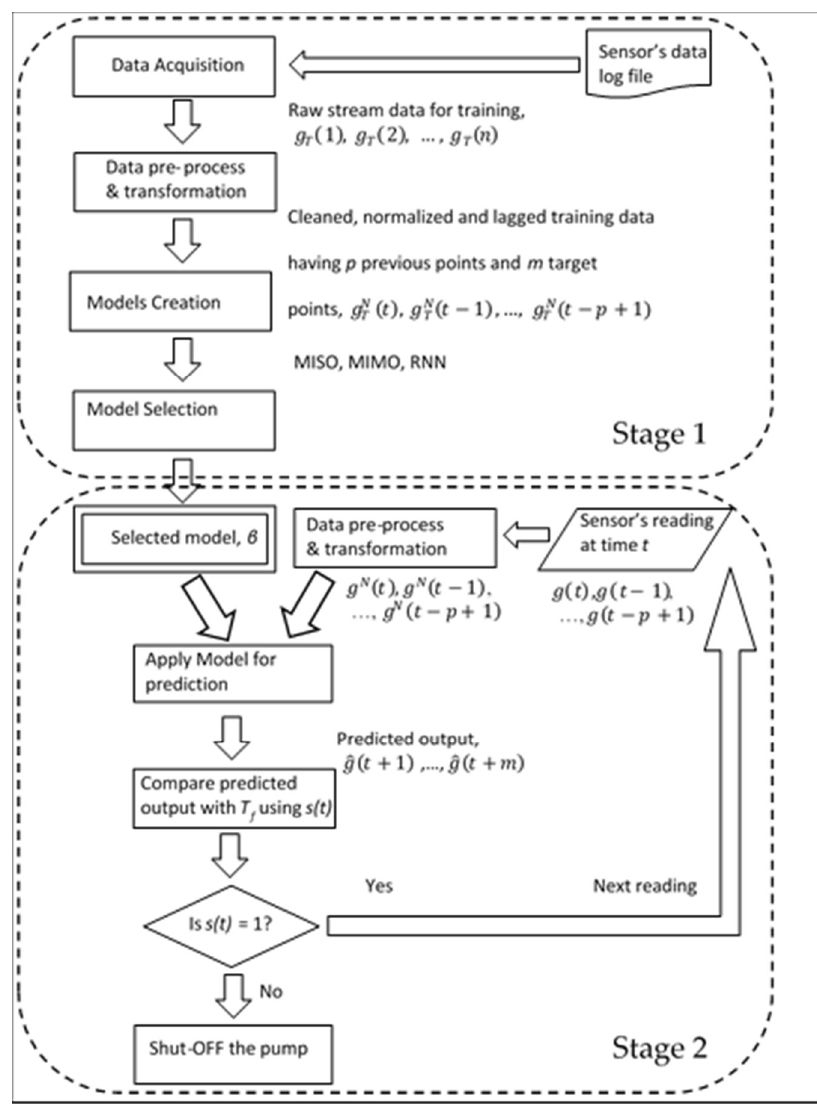
Figure 10. Complete process diagram comprising two